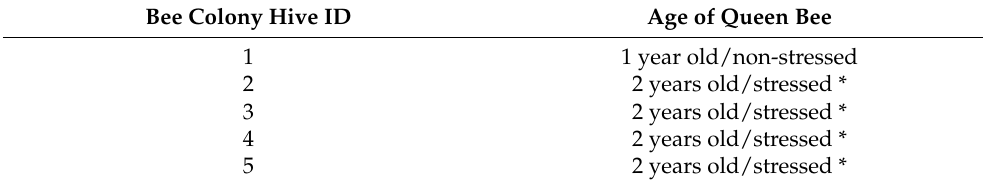
Table 2. Age of the queen bee in different hives of the experiment. Bee Colony Hive ID Age of Queen Bee